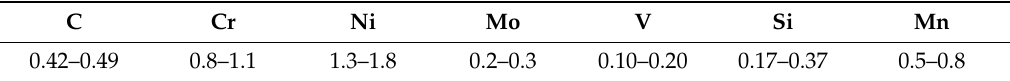
Table 1. Chemical composition of 45CrNiMoVA (wt. %).